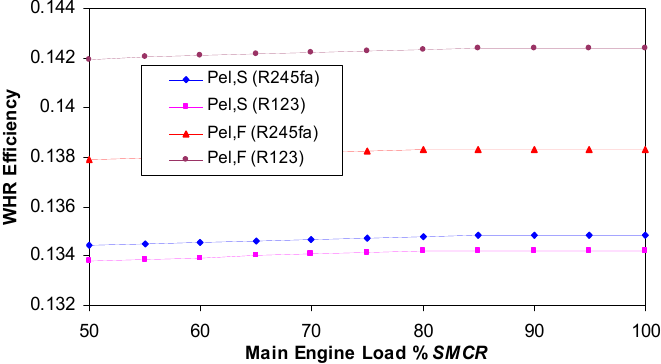
Figure 17. WHR Efficiency with organic fluids— η P,el (electrical power only).